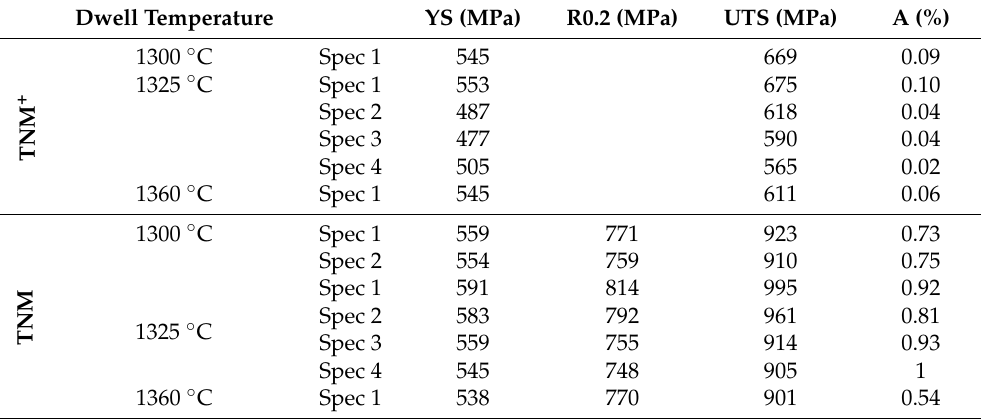
Table 5. Results of tensile tests conducted at room temperature (10 − 4 s − 1 strain rate). Dwell Temperature YS